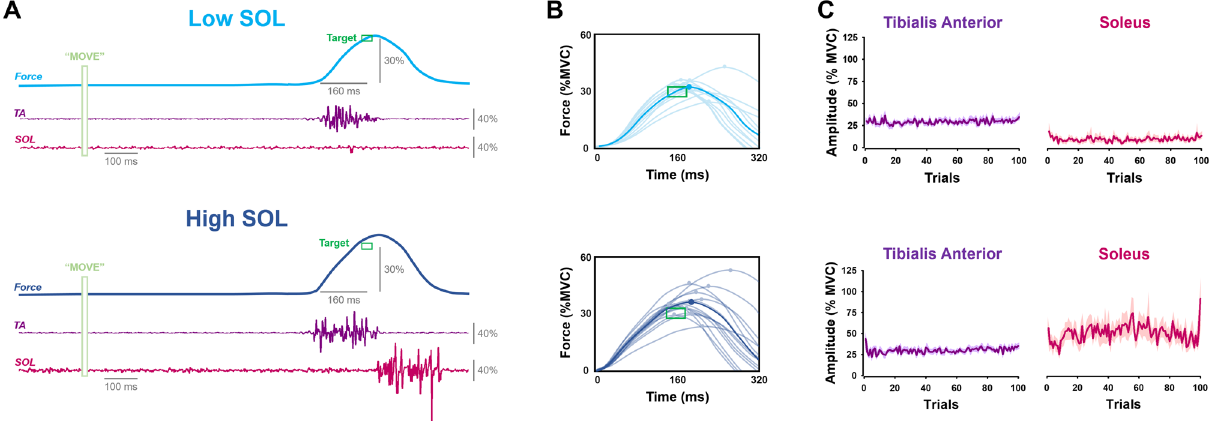
Figure 2. Isometric endpoint control and muscle activation in young adults with altered strategies. Participants performed a goal-directed ankle dorsiflexion contraction with the non-dominant foot that was restrained in an ankle device ( A ). Their goal was to exert an ankle dorsiflexion contraction that reversed at the spatiotemporal target (30% force in 160 ms). We asked participants to perform these goal-directed contractions using strategies similar to what was observed in Experiment 1 between young and old (see Fig. 1). Using a Low SOL coordination pattern (i.e. similar to young), participants performed the task by activating their TA and immediately relaxing. Using a High SOL coordination pattern (i.e. similar to old), participants performed the task by activating the TA during the upward portion followed by immediate activation of the SOL during the downward portion. Using the High SOL coordination pattern, participants exhibited impaired endpoint control ( B ) and altered muscle activity for the Tibialis Anterior (TA) and Soleus (SOL) muscles ( C ). Specifically, TA muscle activity was similar but SOL muscle activity was larger while using a High SOL coordination pattern compared to the Low SOL coordination